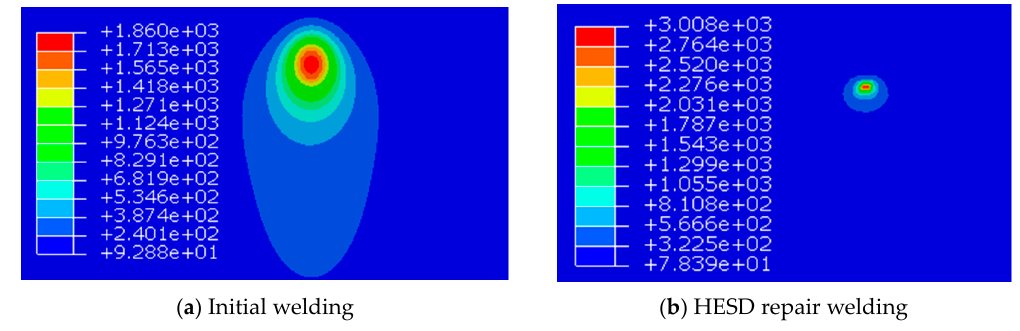
Figure 13. Heat source morphology of the initial welding and HESD repair welding.